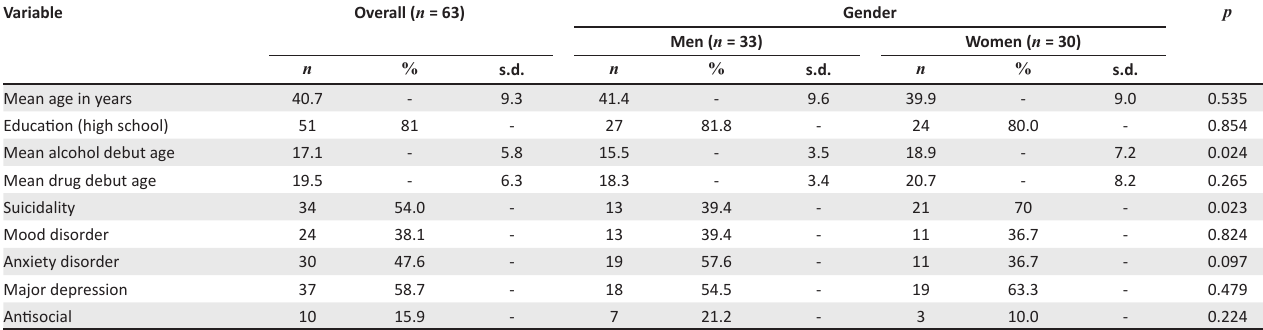
TABLE 4: Selected profile of participants with psychiatric comorbidity. Variable Overall ( n = 63)